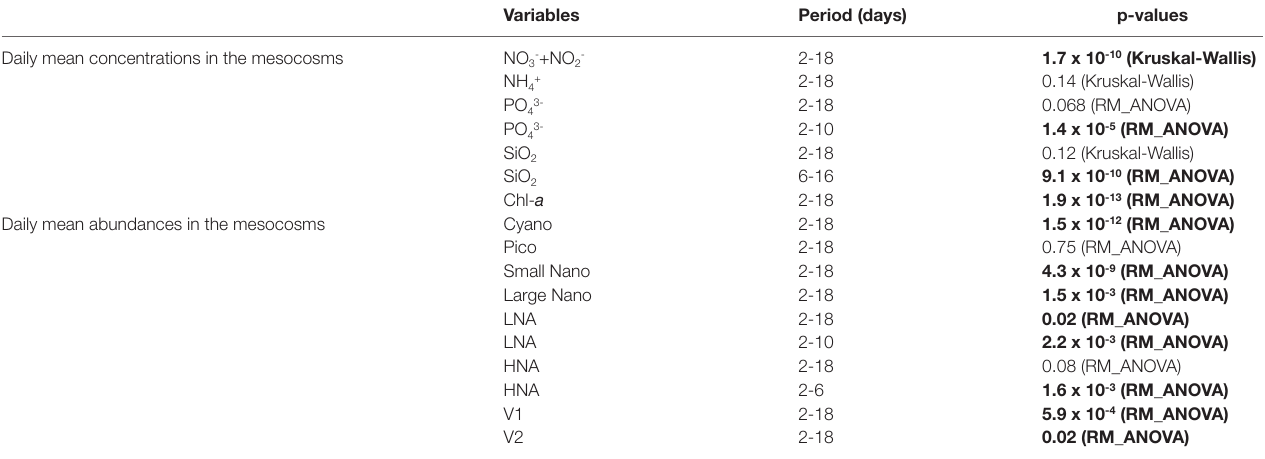
TABLE 1 | Summary table of the p-values of the RM-ANOVA performed between the control and warmed treatment over the warmed period from days 2 to 18, for daily mean Chl- a and nutrient concentrations and daily mean abundance of phytoplankton, bacteria and viruses groups. Variables